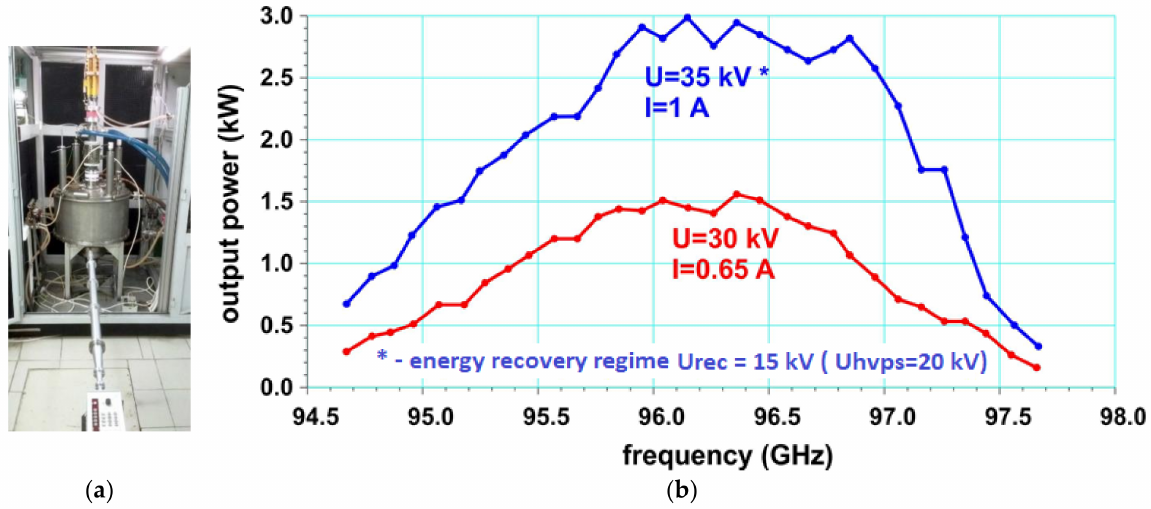
Figure 2. ( a ) GYRO amplifier for ~100 GHz, 3 KW (gyro TWT), and ( b ) its